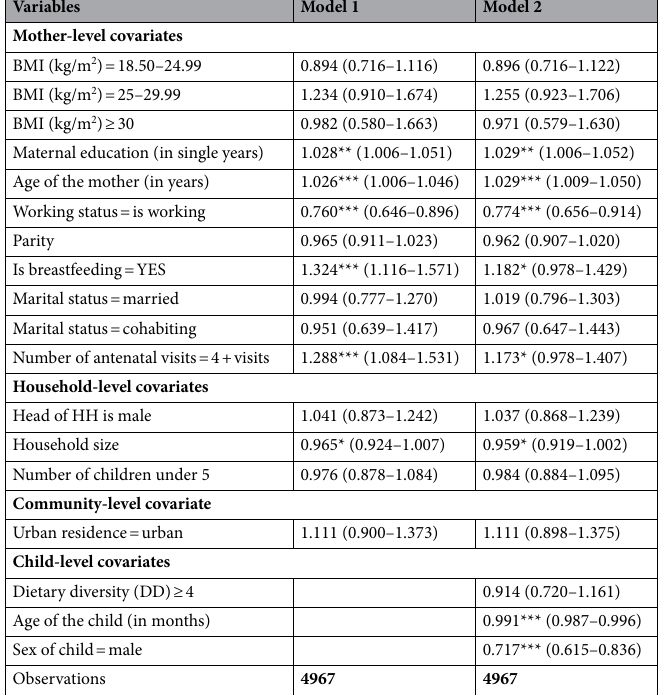
Table 4. Multivariable analysis of the effects of socio-demographic factors on better linear growth/non- stunting among children living in poor households in Kenya. Significant values are in bold. 95% confidence intervals (CIs) in parentheses. DD dietary diversity, HH household, BMI body mass index. *** p < 0.01, ** p < 0.05, * p <